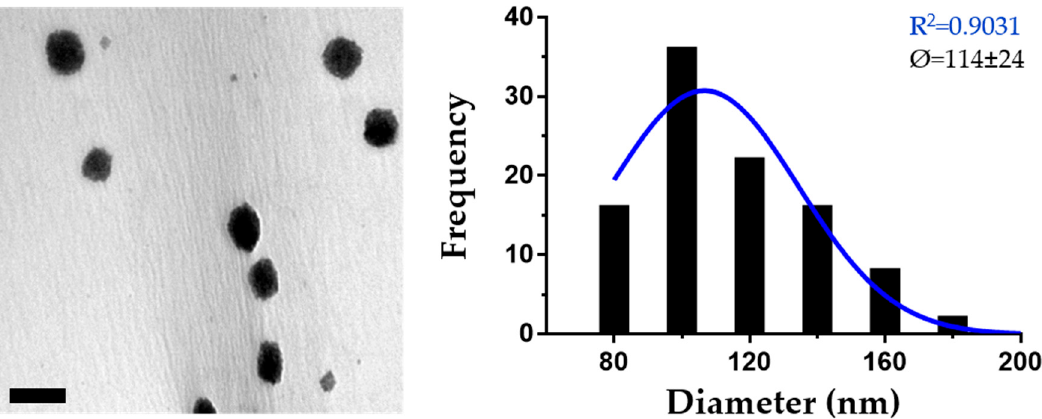
Figure 3. TEM analysis of optimized PMVE / MA-Es nanoparticles. Representative TEM image and diameter frequency histogram of PMVE / MA-Es nanoparticles synthesized by the solvent displacement method. The histogram was generated from data obtained from multiple images, until reaching 50 individual measurements. The best-fit adjustment (and R 2 ) to a Gaussian distribution is indicated in blue. Average diameter (Ø) and s.d. are also included in the inset. Scale bar: 200 nm.